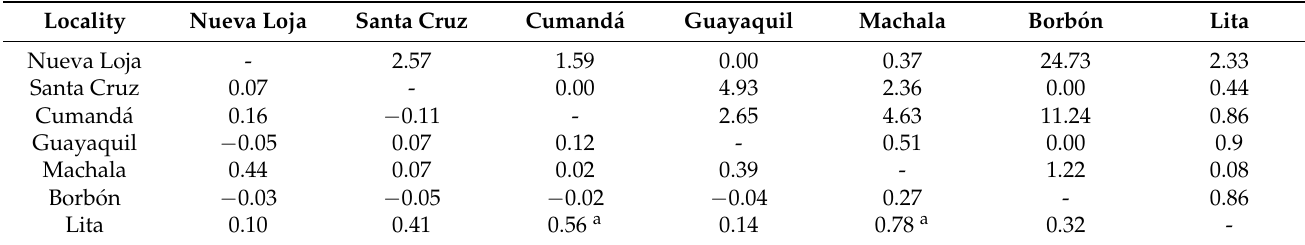
Table 4. Genetic distances (FST values; below the diagonal), and the number of migrants per generation (Nm; above the diagonal), among seven populations of Aedes aegypti from continental and insular regions of Ecuador. p -value: a p < 0.05. Locality